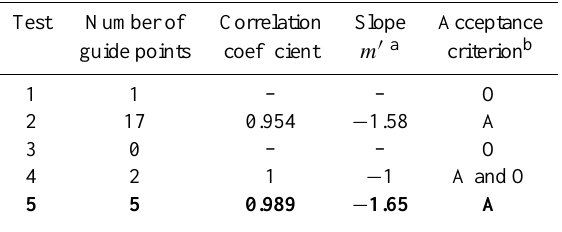
Table 3. Example of ACTA’s Step I. a m(t) = − 1 . 36, b O: orienta- tion, A: alignment. Due to the characteristics of the contrail, only Test 5 provides a satisfactory output to continue the